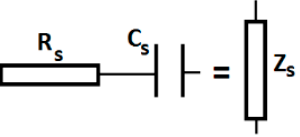
Figure 9. Equivalent electrical circuit for the real CCs: (cid:1844) (cid:3046) , resistor; (cid:1829) (cid:3046) , capacitance; (cid:1852) (cid:3046) , series im- pedance.